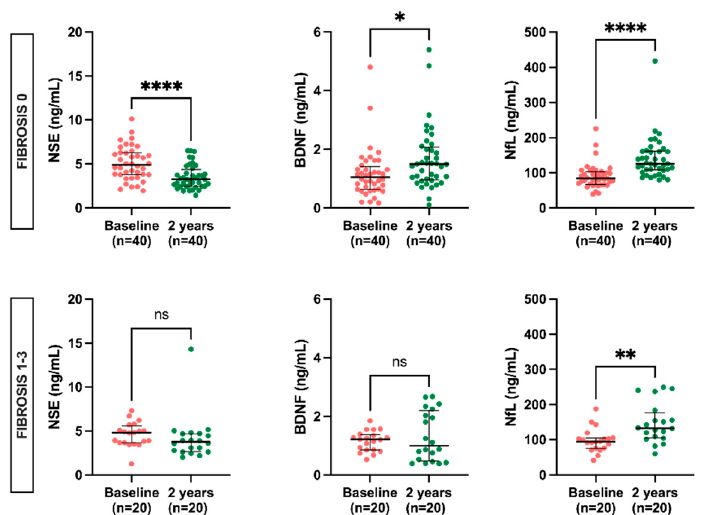
Figure 4. Levels of NSE, BDNF, and NfL at baseline vs. 2 years post-KT according to fibrosis score. Results are presented as the median and IQR. Differences between baseline and two years post-KT were analyzed using the Wilcoxon paired test. * p < 0.05, ** p < 0.01, **** p <